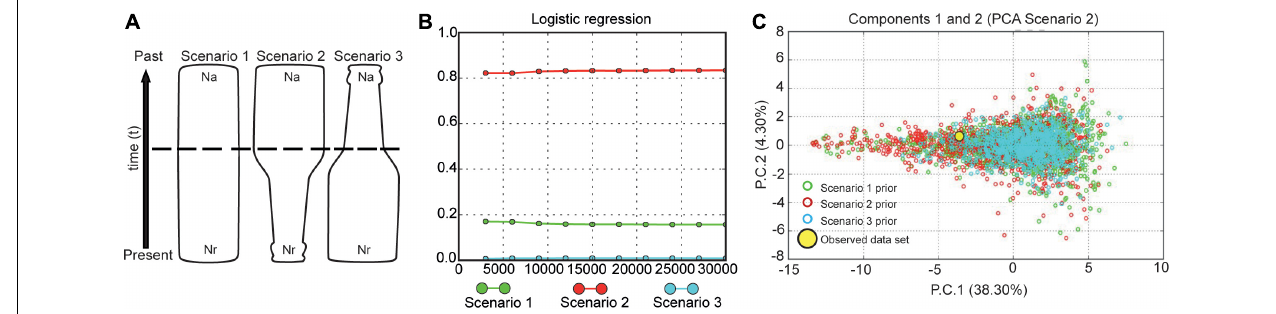
FIGURE 3 | Possible demographic history scenarios for the Myrmecophaga tridactyla population. (A) Representation of three demographic scenarios evaluated by DIYABC. Legend: the areas of the figures represent changes in population size through time. Effective population size (Ne) is represented by Na (ancestral effective population size) and Nr (recent effective population size). The time, t, in number of generations. Scenario 1 without a change in an ancestral population experiencing (null hypothesis); scenario 2 with a change in Na at time t, representing a bottleneck event, Nr < Nr; and scenario 3 with a change in Ne at time t, representing an expansion event, Nr > Na. (B) Posterior probabilities of the three scenarios obtained by logistic regression of 1% of the closest simulated datasets. The most probable demographic scenario for M. tridactyla population was a historical bottleneck. Posterior probability of each scenario in the y- and x-axes indicates the number of simulated data closest to observed data. (C) Graphic of principal components analysis (PCA) generated in DIYABC displaying the fit between scenarios simulated and our dataset.